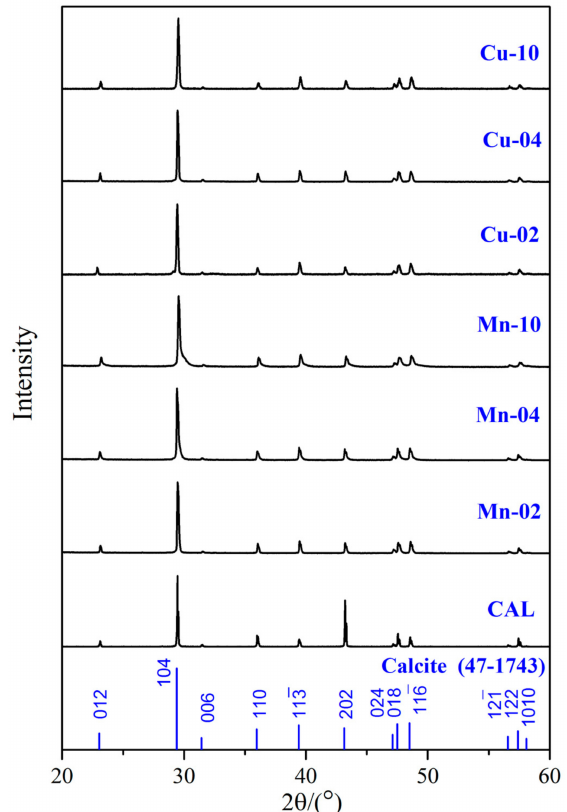
Figure 1. X-ray diffraction (XRD) patterns of the synthesized solid